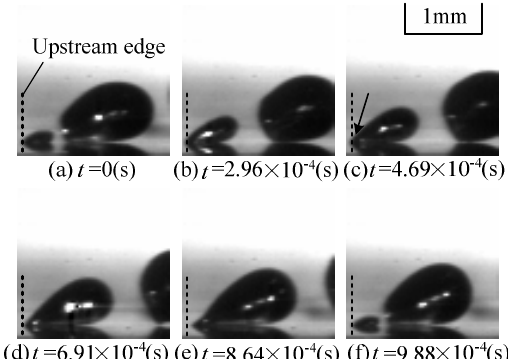
Fig.5 Process of bubble growth and separation = 0.32 mm, U ( d 0